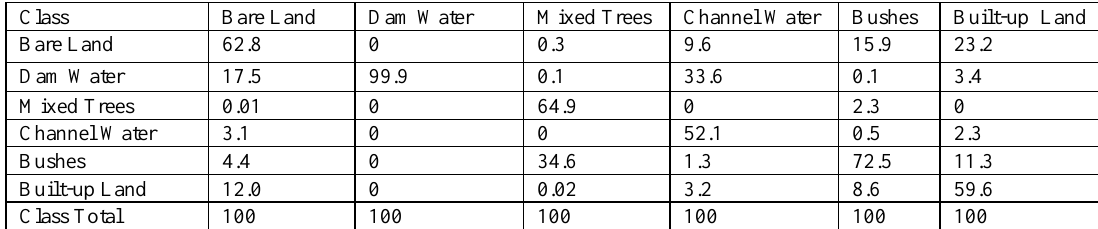
Table 7: Change Detection Percentage Operational Land Imager Data from Summer to Autumn Season Class Bare Land Dam Water Mixed Trees Channel Water Bushes